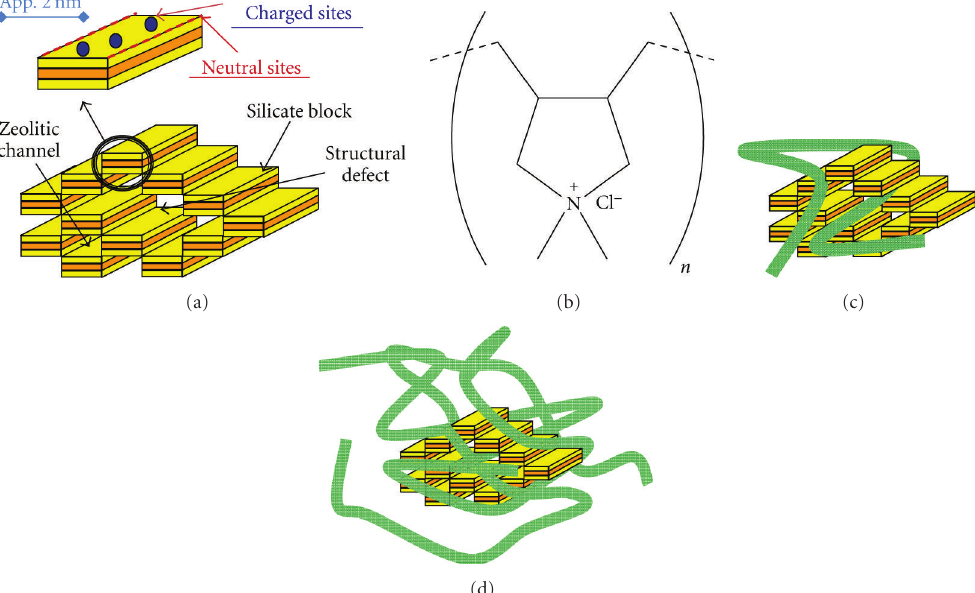
Figure 1: Schematic structure of (a) a single block and connected blocks of sepiolite. The 2nm size bar is given as a relative dimension; (b) poly-DADMAC monomer molecule; (c) low-charge nanocomposite suitable for winery e ffl uents. The ribbons illustrate the polymer chains with positive charges distributed throughout; (d) high-charge nanocomposite suitable for olive mill e ffl uents.